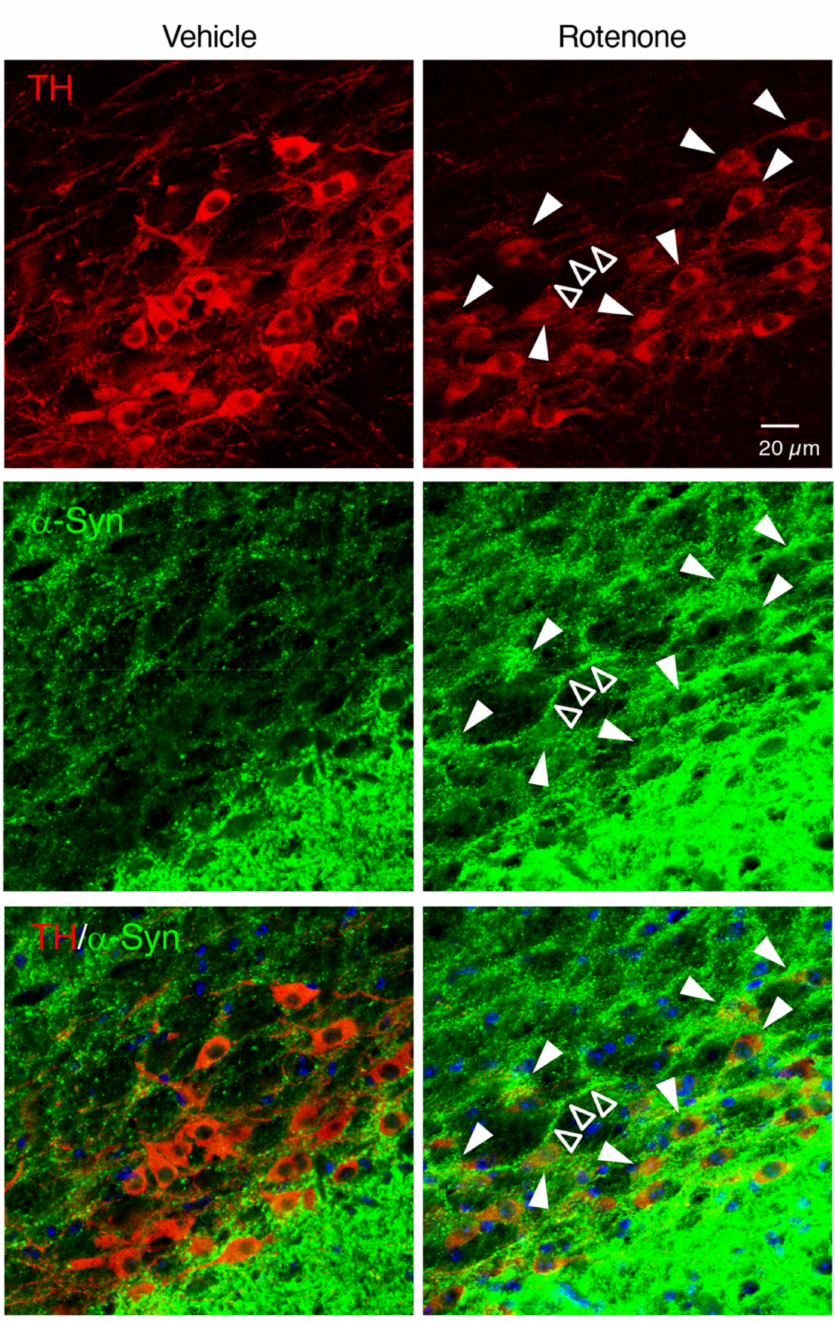
Figure 6. Chronic exposure to low-dose rotenone induced α -synuclein ( α -Syn) accumulation in dopaminergic neurons in the SNpc of mice. Representative photomicrographs of TH and α -Syn double immunostaining in the SNpc of mice. Red: TH-positive neurons. Green: α -Syn. Blue: nuclear staining with Hoechst 33342. Solid arrowheads: increased α -Syn signals in TH-positive neuronal soma. Open arrowheads: α -Syn-positive neurite. Scale bar = 20 µ